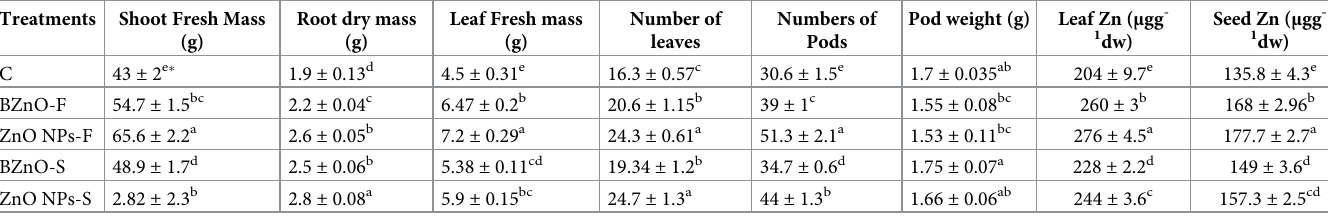
� : mean ± standard deviation (SD); Mean values followed by a different letter (s) are significantly different according to Tukey’s